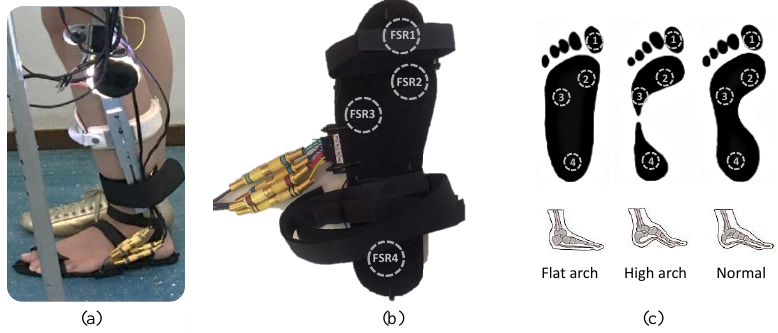
Figure 5. ( a ) instrumented insole implemented at the active knee orthosis; ( b ) FSR locations; ( c ) FSR locations at flat arch, high arch and normal